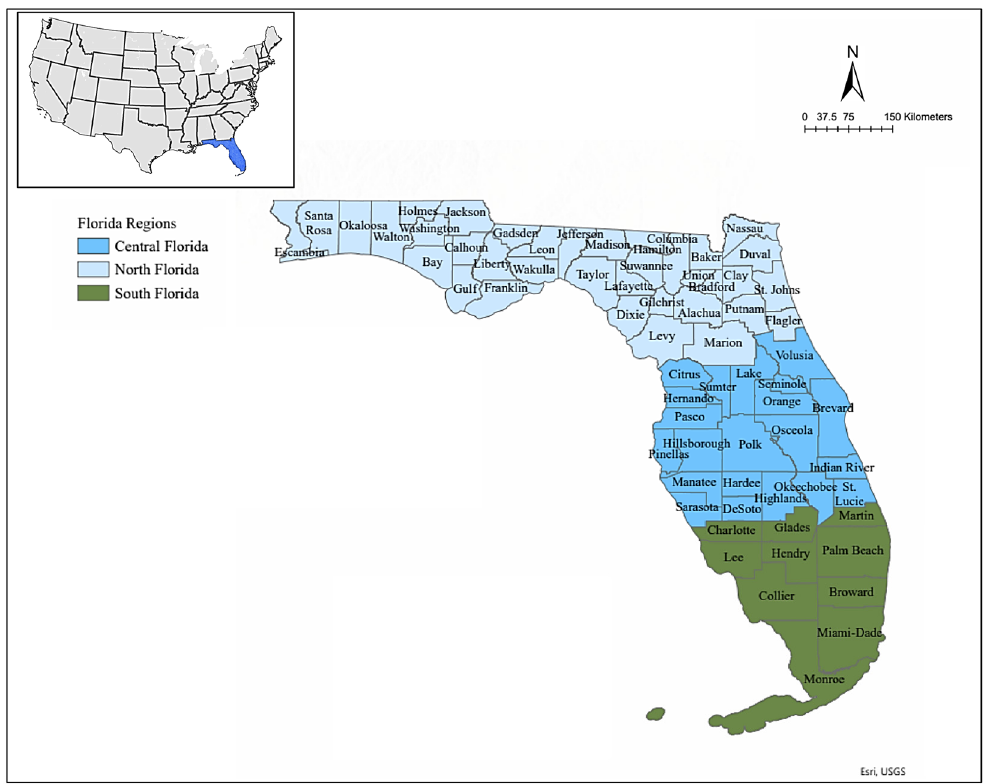
Figure 1. Map of Florida: counties and three Florida’s regions (north, central, and south). The state of Florida has been divided into three to six regions. The six (6) region classification includes: northwest, northeast, central, central west, southwest, and south- east [35], while the five (5) region classification consists of: panhandle, north, north